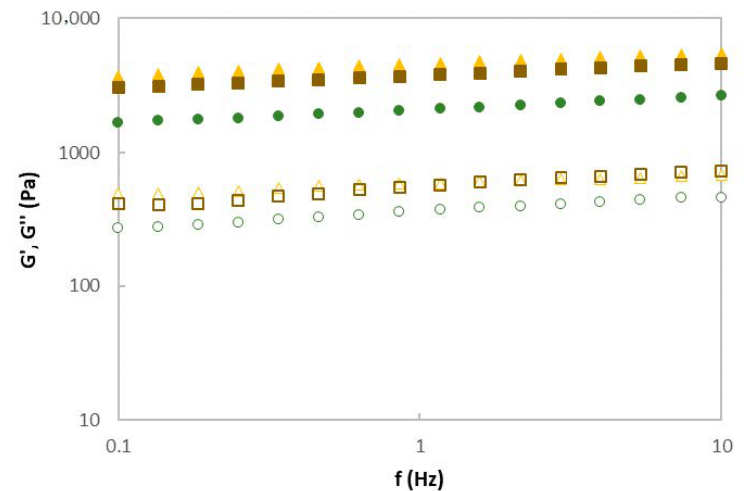
Figure 2. Mechanical spectra of starch-based hydrogels enriched with representative Paulownia extracts treated at the lowest autohydrolysis temperature (140 °C). Symbols: G ′ (closed), G ′′ (open), bark (squares), leaves (circles), petioles (triangles).